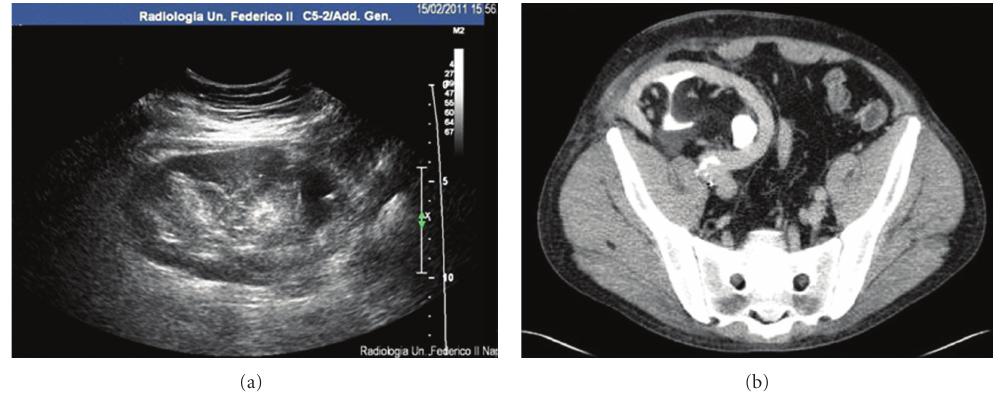
Figure 2: (a) US and (b) CT scan (with contrast medium) performed after the resolution of acute renal impairment, showing the persistence of a mild dilatation of upper calyces and the impregnation with contrast media of pelvicalyceal structures. The entity of perirenal fat is not